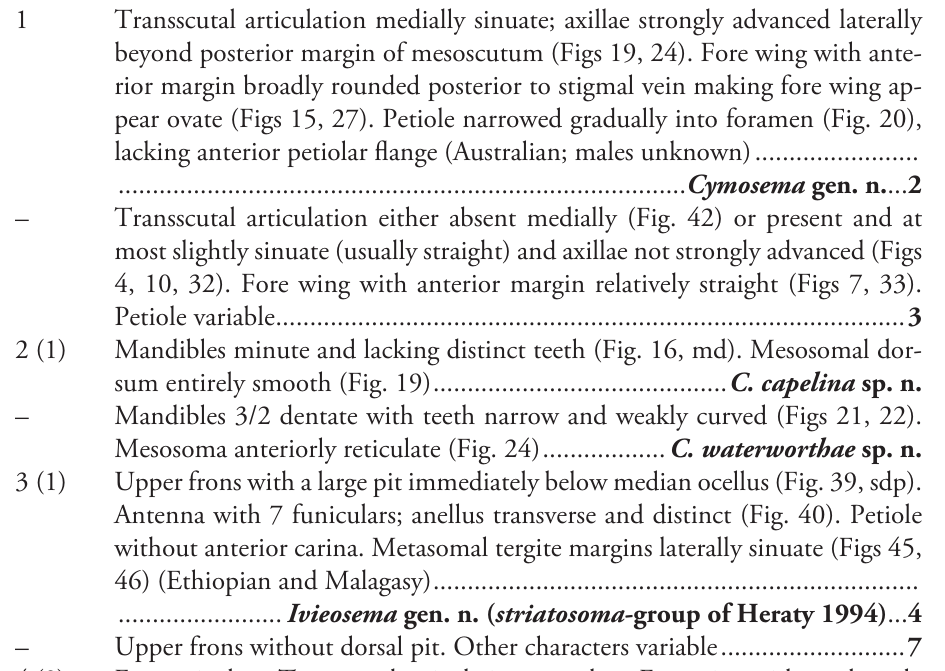
1 Transscutal articulation medially sinuate; axillae strongly advanced laterally beyond posterior margin of mesoscutum (Figs 19, 24). Fore wing with ante- rior margin broadly rounded posterior to stigmal vein making fore wing ap- pear ovate (Figs 15, 27). Petiole narrowed gradually into foramen (Fig. 20), lacking anterior petiolar flange (Australian; males unknown) ........................ ................................................................................... Cymosema gen. n. ... 2